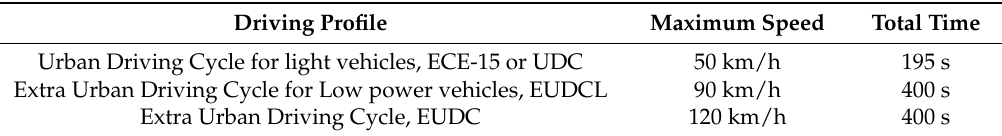
Table 1. European driving profiles.